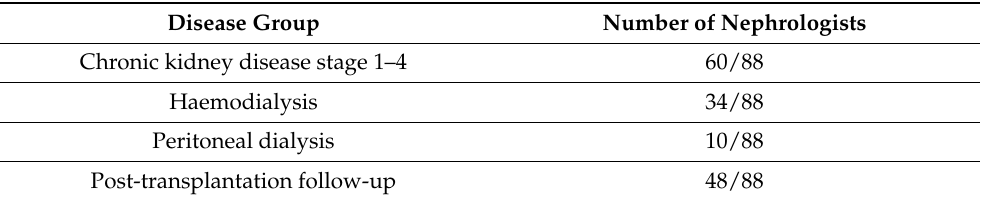
Table 1. Distribution of renal diseases (88 adult nephrologists currently caring for adolescents and young